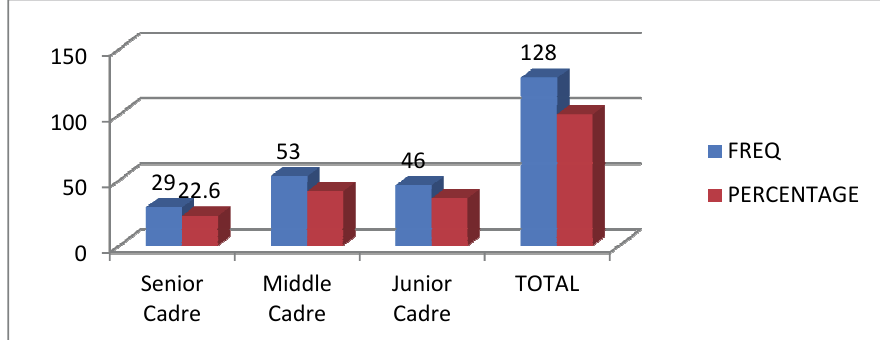
Source: Field Survey, November